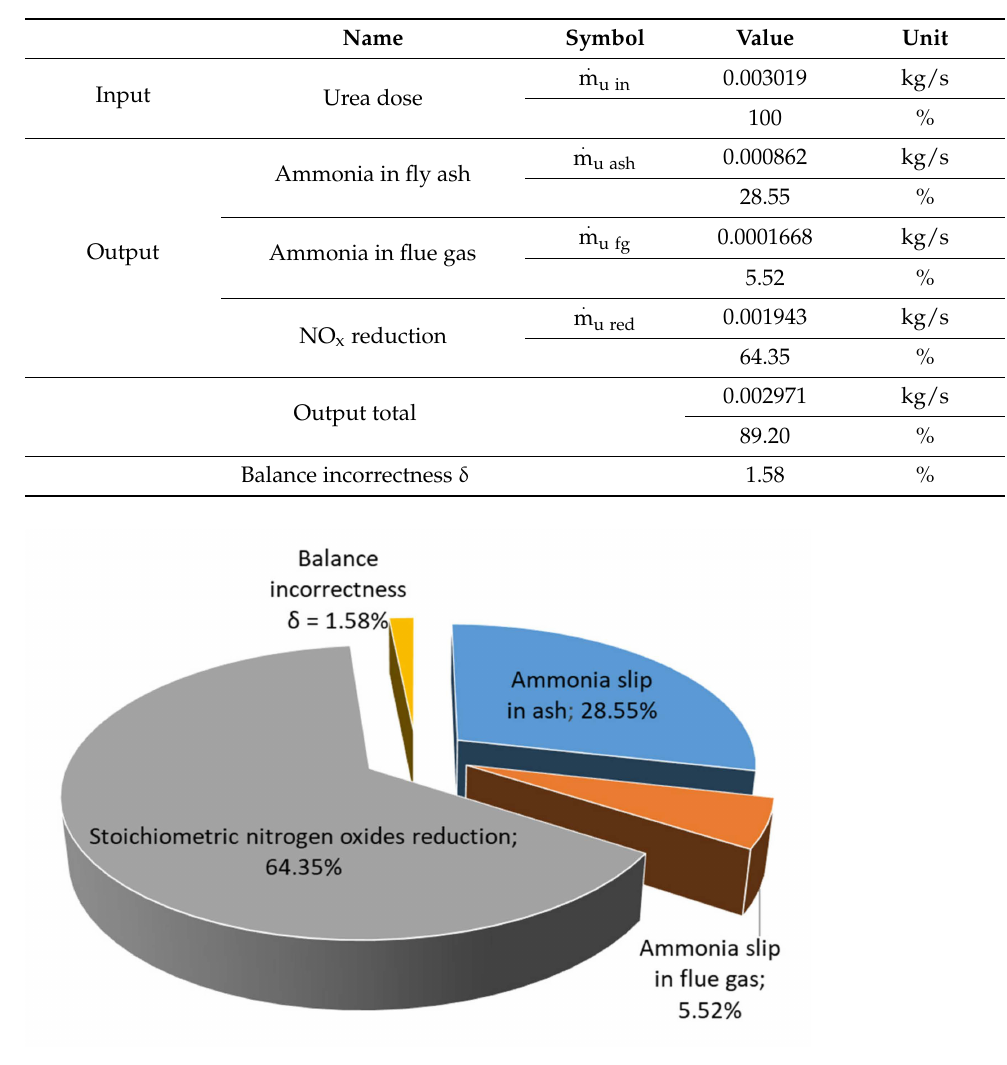
Figure 12. Ammonia mass balance for the FJBS+